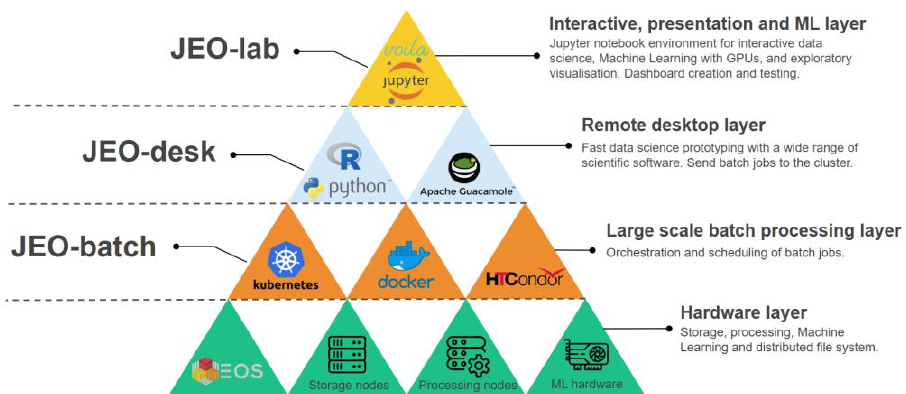
Figure 1. Graphical representation of BDAP components (Acknowledgement: JRC Big Data Ana- lytics project)